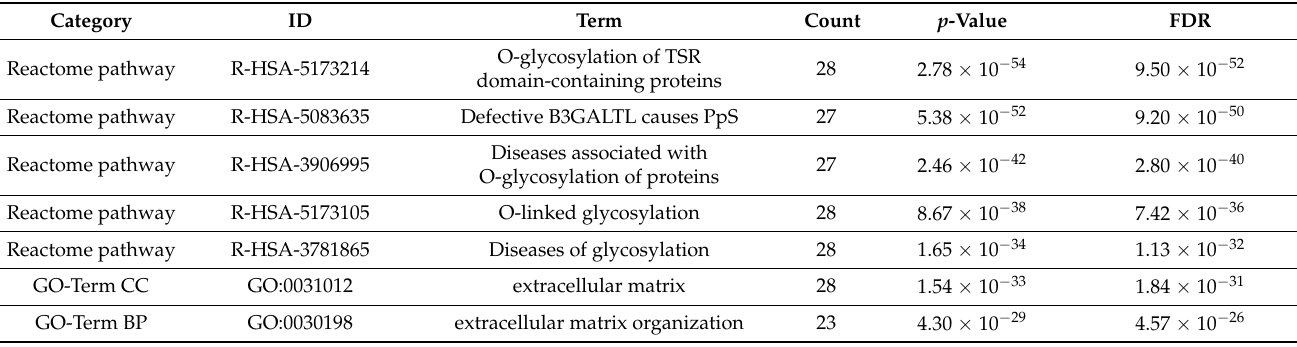
Table 1. Functional enrichment of the PPI